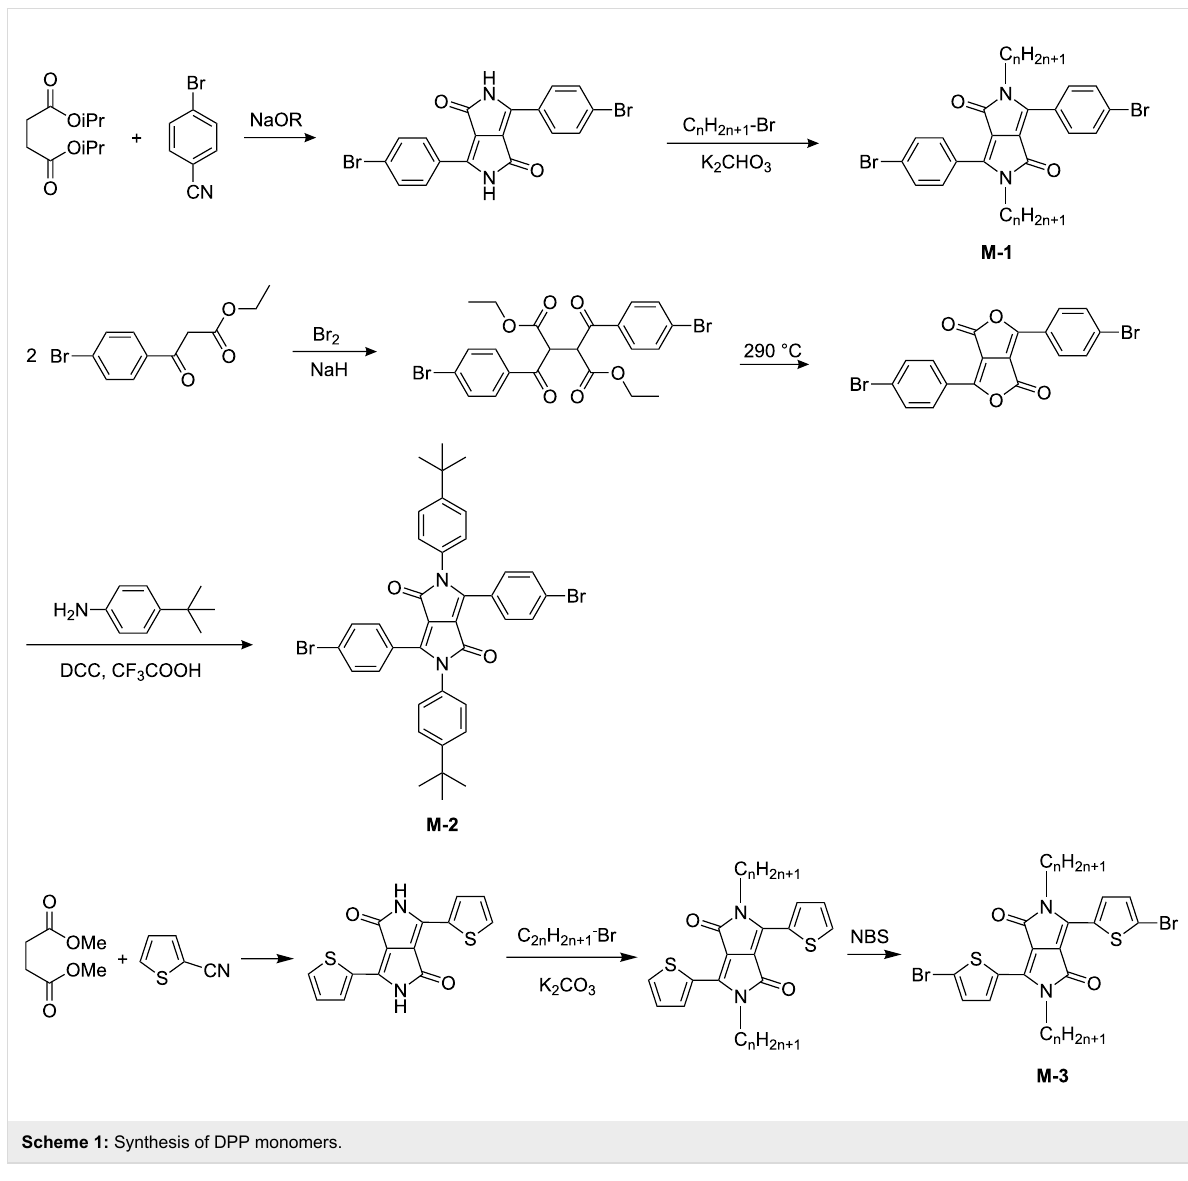
Figure 2. DeSchryver et al. synthesized dendrimer